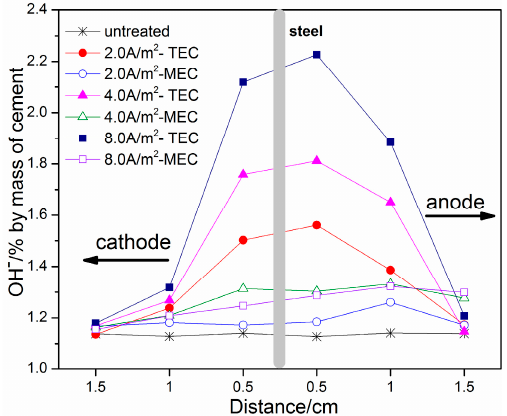
Figure 7. Concentrations of OH − ions as a function of location (untreated, after the TEC treatment and the MEC treatment).